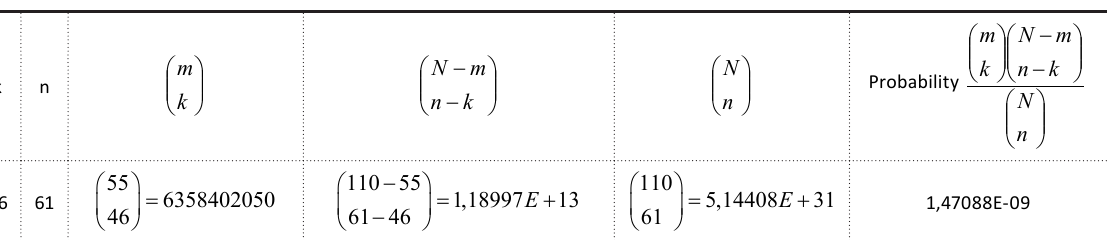
Table 3. Exact test – hypergeometric distribution – hypothesis No.